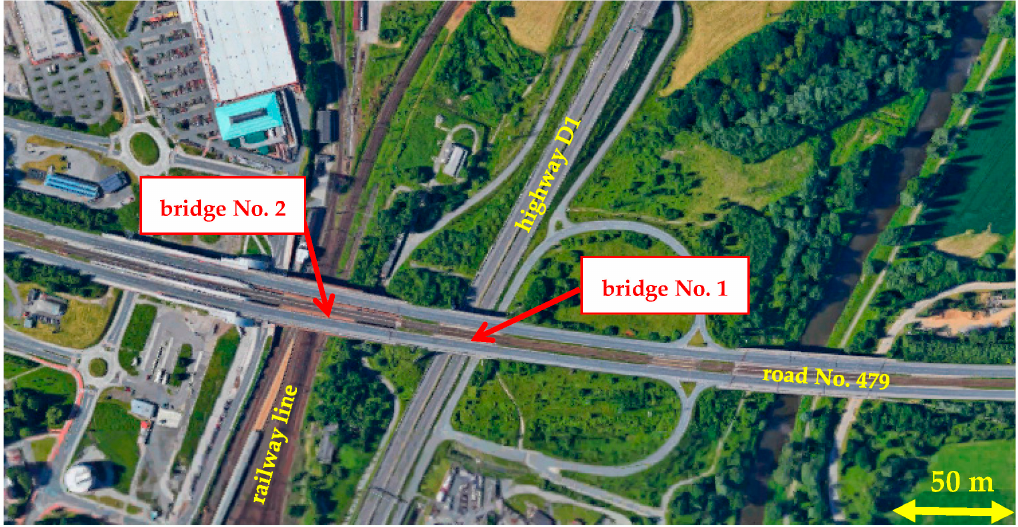
Figure 2. Location of the bridge structures.